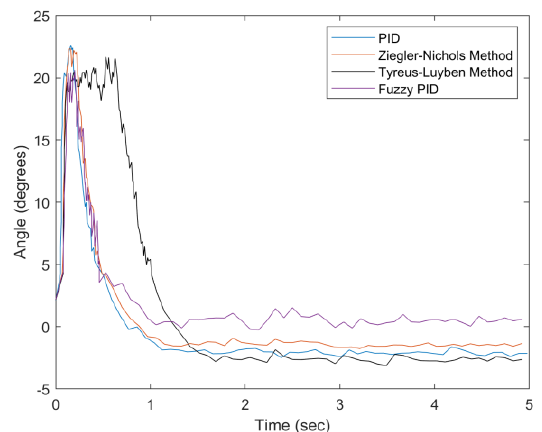
Figure 34. Tilt angle is approximately 20 degrees.